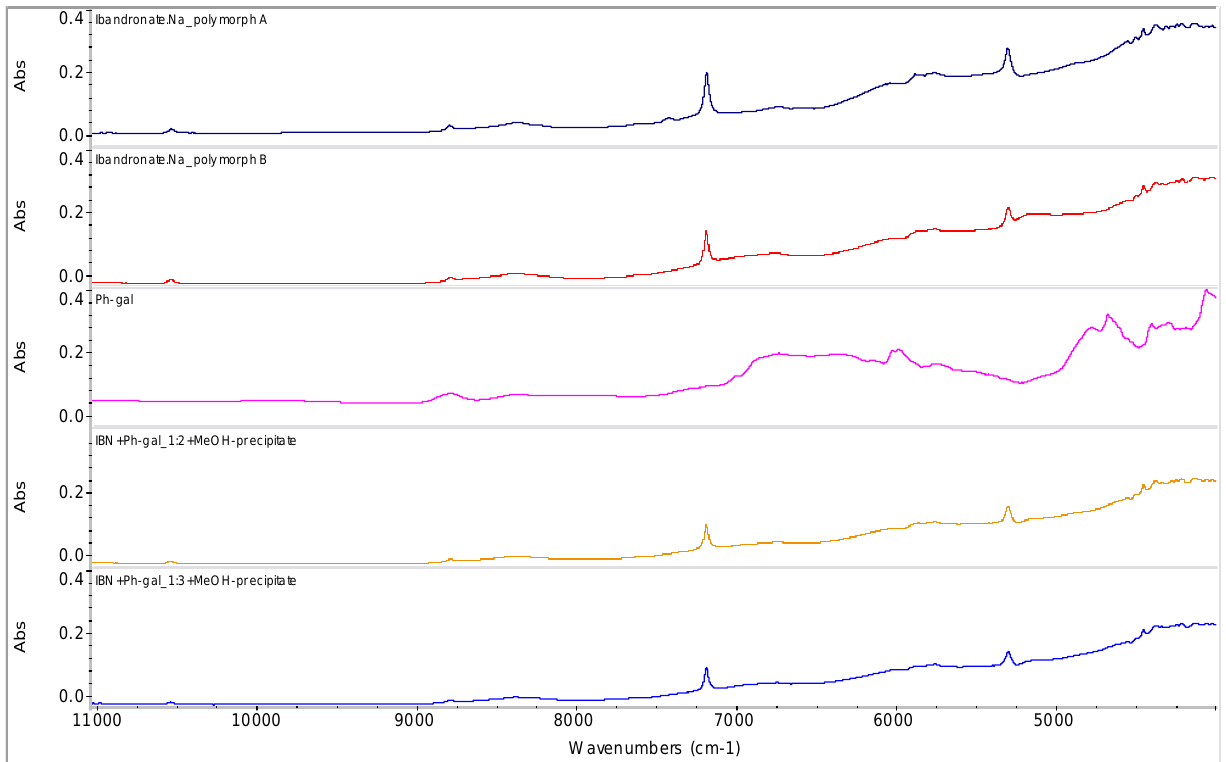
Figure 8. NIR spectra of ibandronate (IBN) monosodium salt forms A and B, phenyl- β - D - galactopyranoside (Ph-gal) and spectra of their mixtures in ratios 1:2 and 1:3 prepared by methanol precipitation (samples 4 and 5